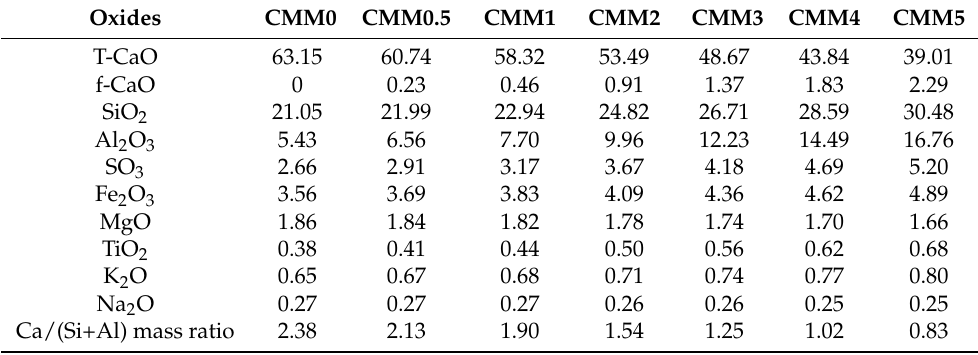
Table 3. Chemical components of CMM (mass